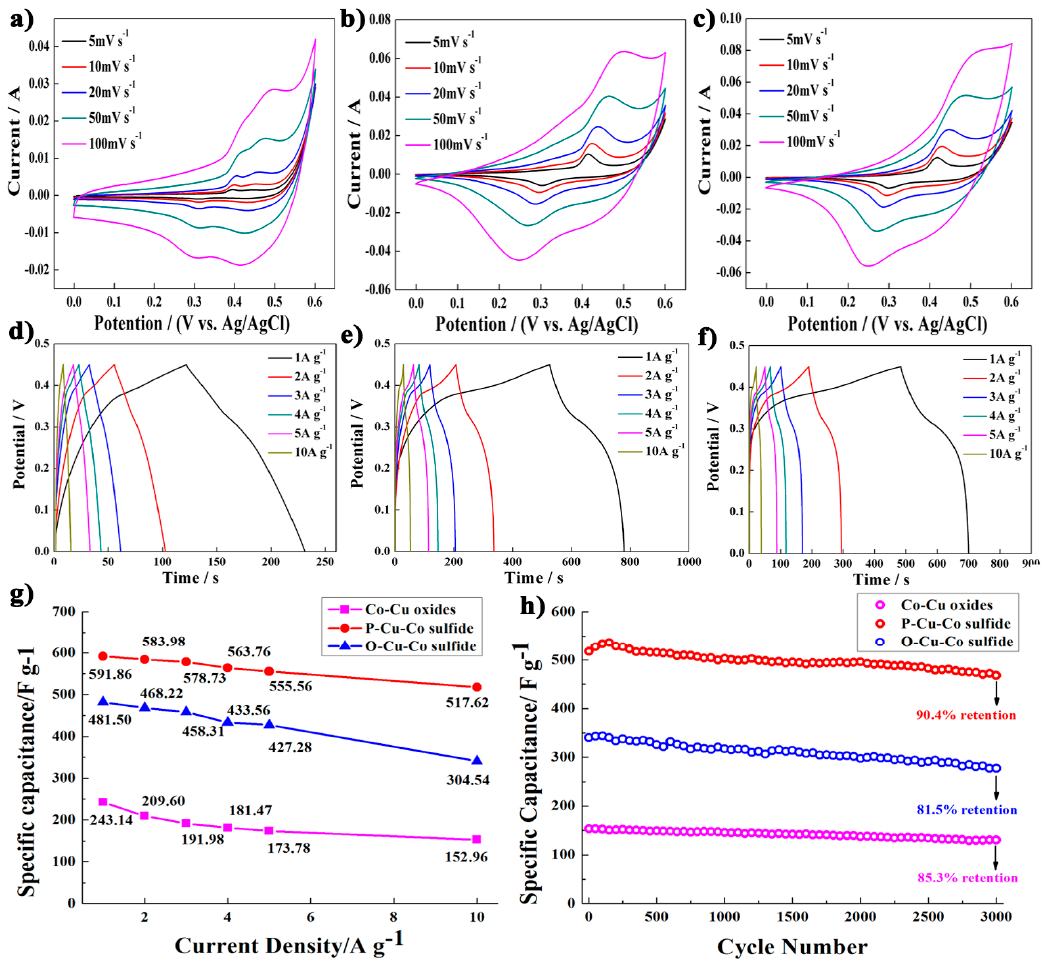
Figure 5. ( a ) CV curves of Cu–Co oxide; ( b ) CV curves of P–Cu–Co sulfide; ( c ) CV curves of O–Cu–Co sulfide; ( d ) GCD plots of Cu–Co oxide; ( e ) GCD plots of P–Cu–Co sulfide; ( f ) GCD plots of O–Cu–Co sulfide; ( g ) Specific capacity of Cu–Co oxide, P–Cu–Co sulfide, and O–Cu–Co sulfide; ( h ) Cycling